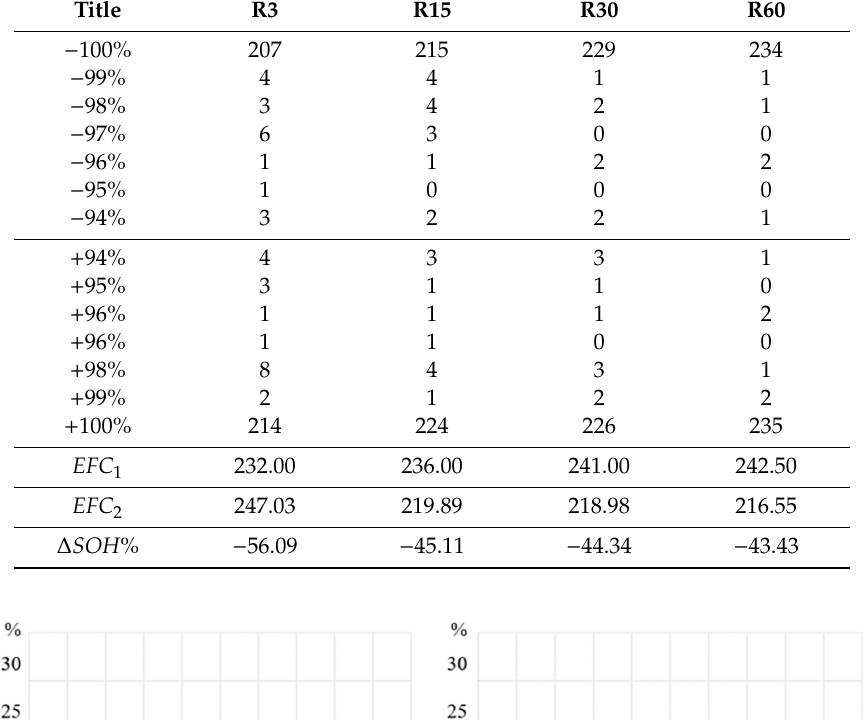
Table 9. Batteries life estimation.